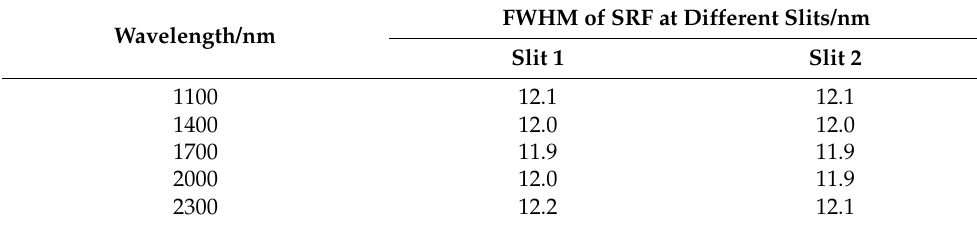
Figure 21. ( a ) Test device for B3 spectrometer, ( b ) spectral lines and SRFs of B3 spectrometer. Table 6. Spectral resolution of B3 spectrometer with 2 × pixels binning.